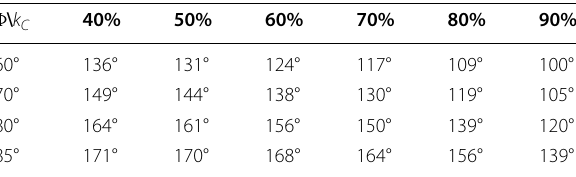
Table 1 Value of ϕ max under different conditions